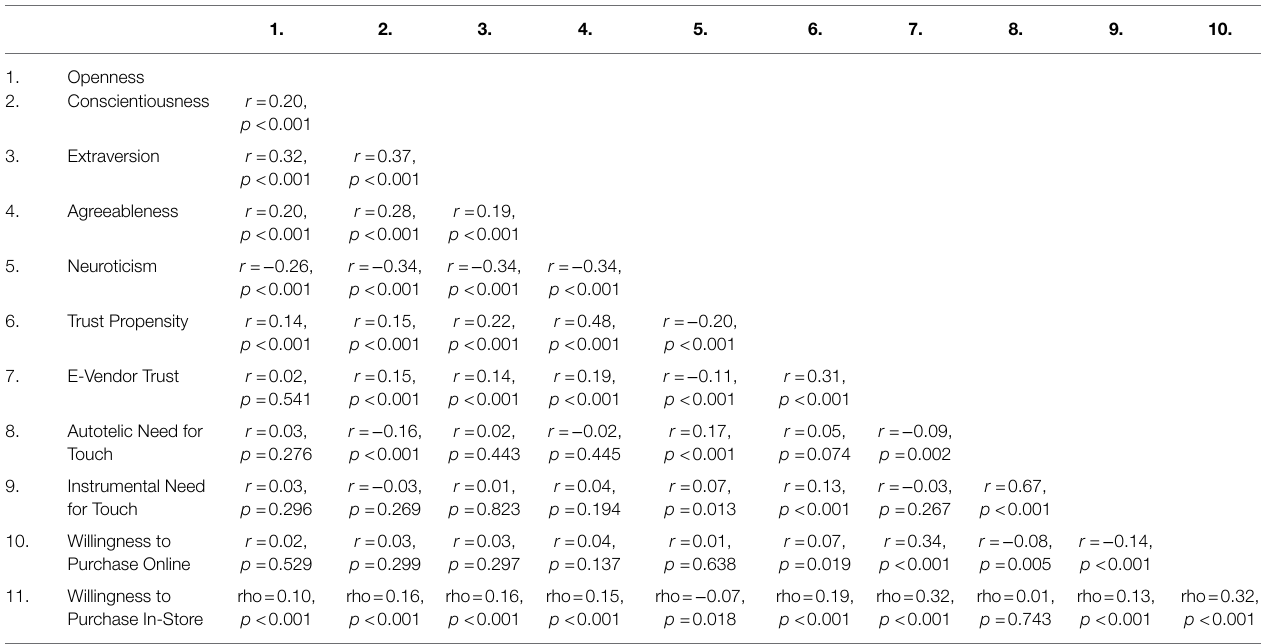
TABLE 2 | Zero-order bivariate correlations between study variables in the total